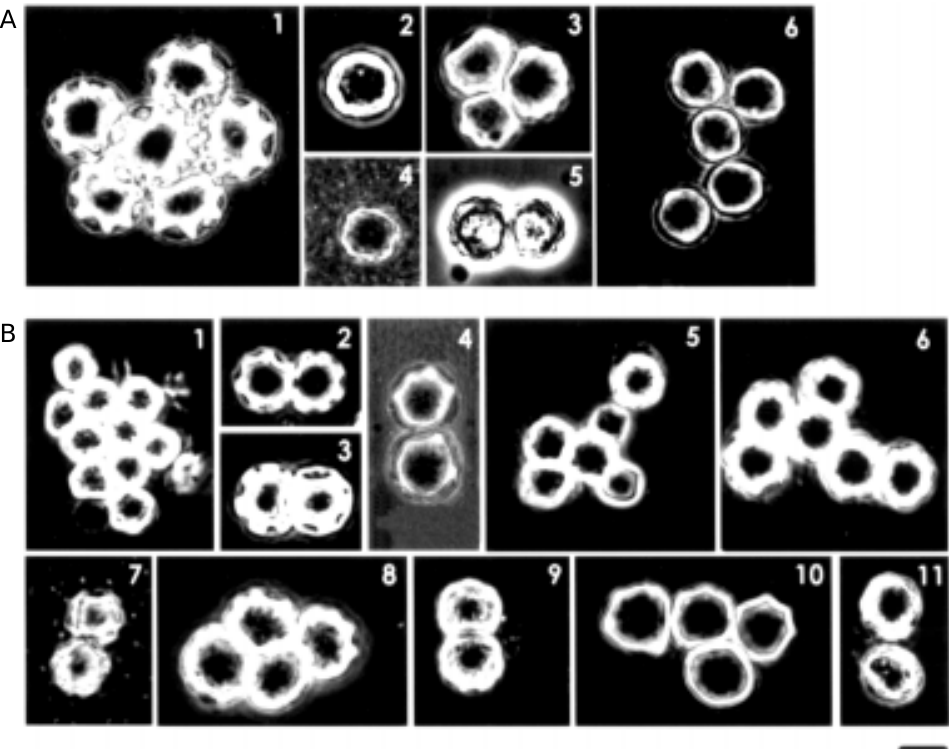
Figure 1 - Representative cysts of Acanthamoeba isolates pho- tographed by phase microscopy and digitally processed. A , ATCC reference isolates - 1: